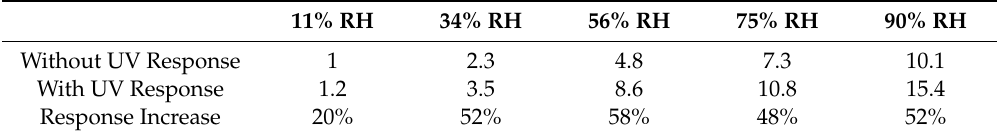
Figure 4. The humidity responses with and without UV. The inset illustrates the schematic diagram of the SnO 2 / silicon nanopillar array sensor with UV light. Table 1. The humidity responses with and without UV.